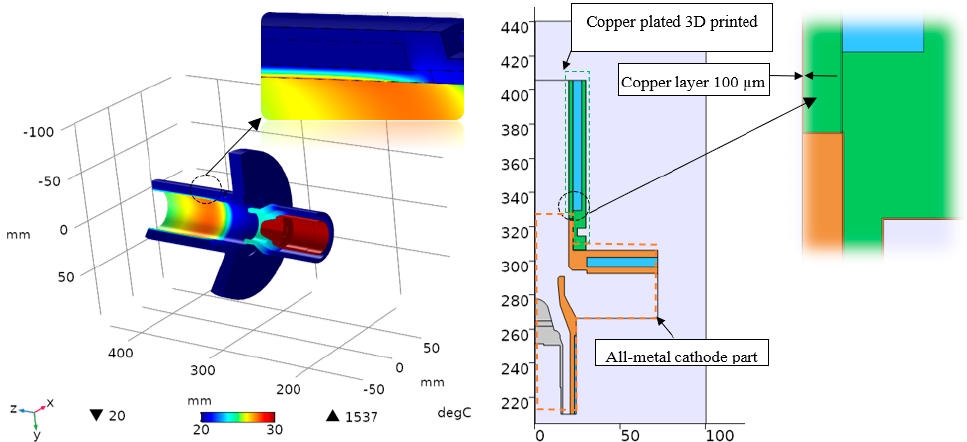
Figure 2. Temperature distribution in the cathode-anode unit: green indicates a 3D printed photo- polymer part, orange indicates a copper solid part or a copper coating of a polymer part, and blue indicates a water-cooling channel.